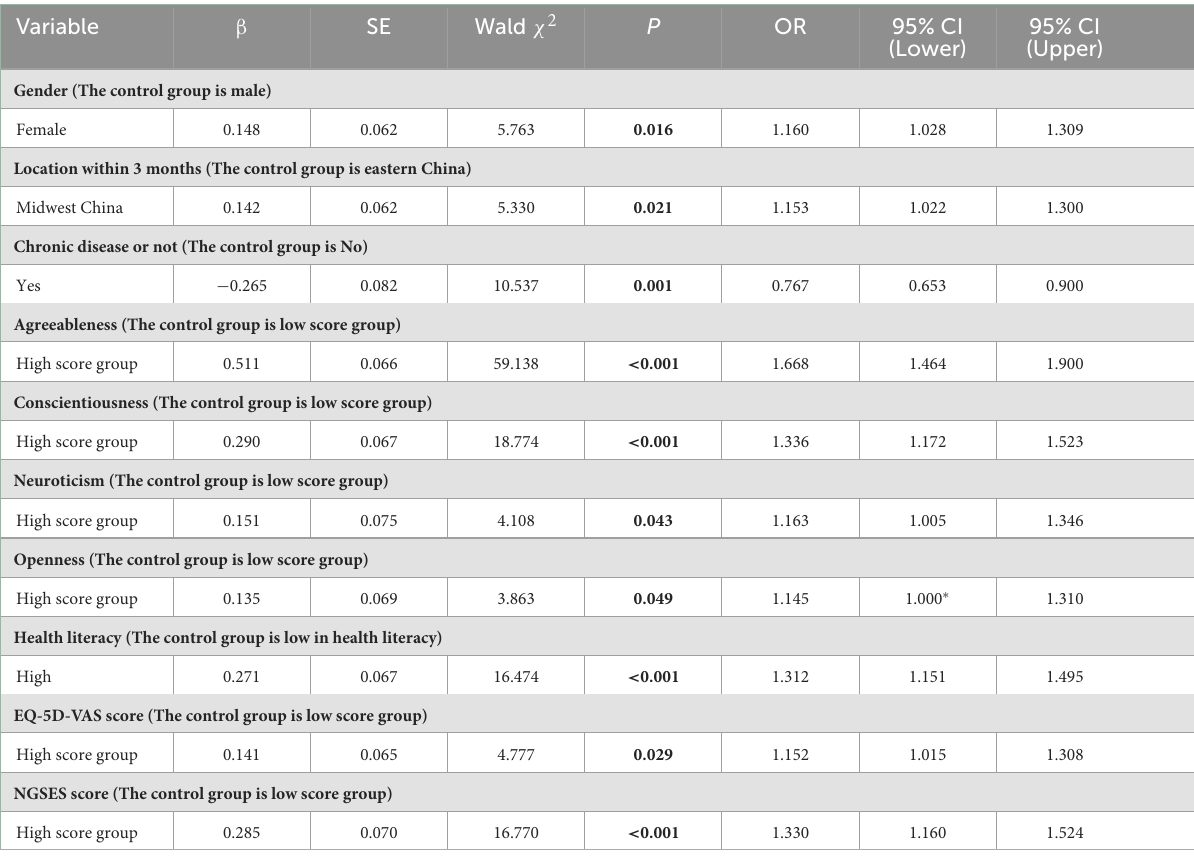
TABLE 7 Stepwise multivariate binary logistic regression results of whether the respondents take the suggestions of medical personnel as an important consideration when purchasing OTC drugs.